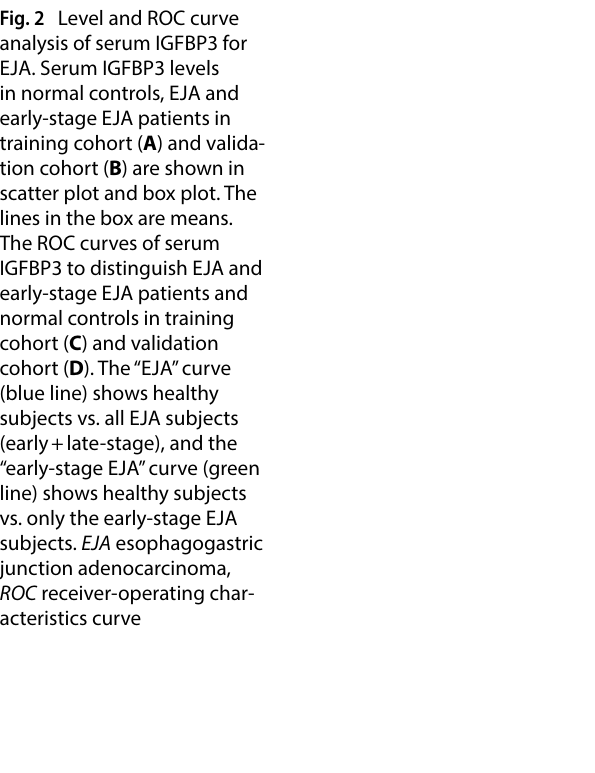
Table 2 Diagnostic results of serum IGFBP3 in EJA